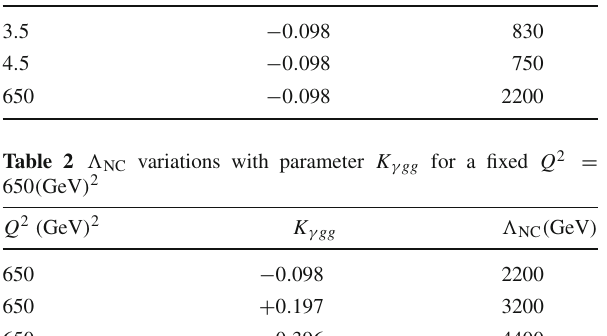
Table 1 (cid:4) NC variations with squared transfer momentum for a fixed K γ gg = − 0 . 098 Q 2 ( GeV ) 2 K γ gg (cid:4) NC ( GeV )